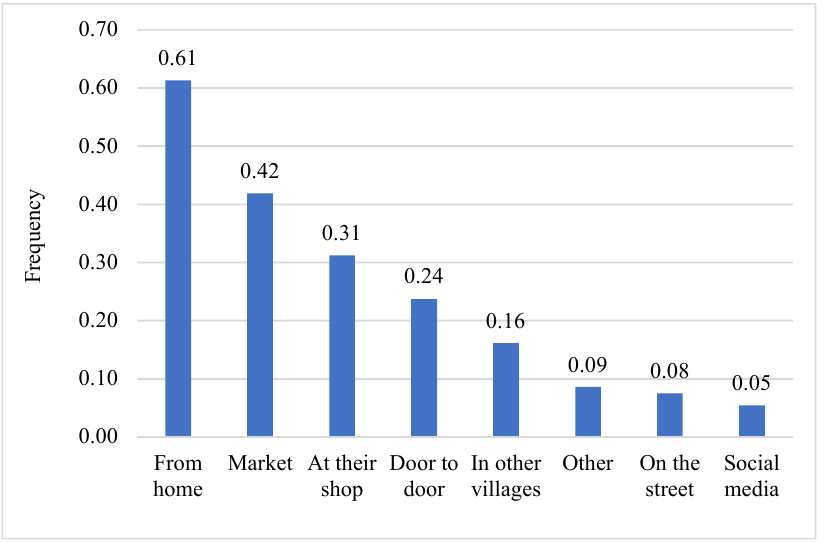
Figure 5. Locations Where Women Sell Instant Flours.